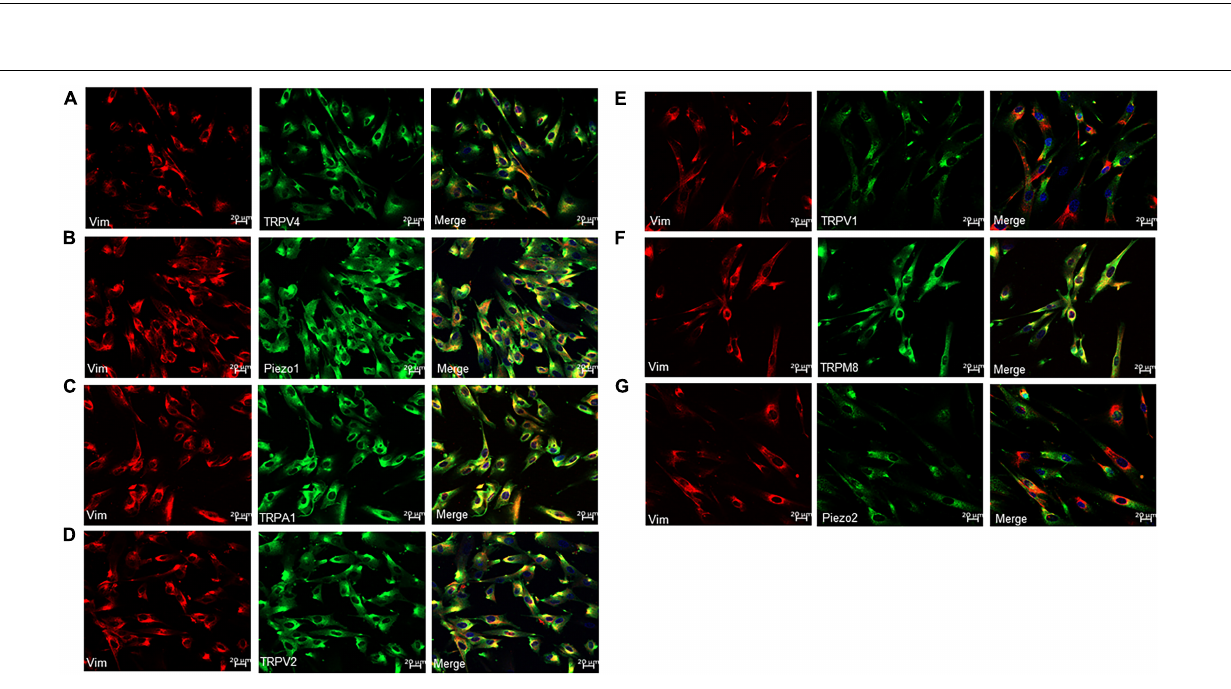
Frontiers in Physiology |